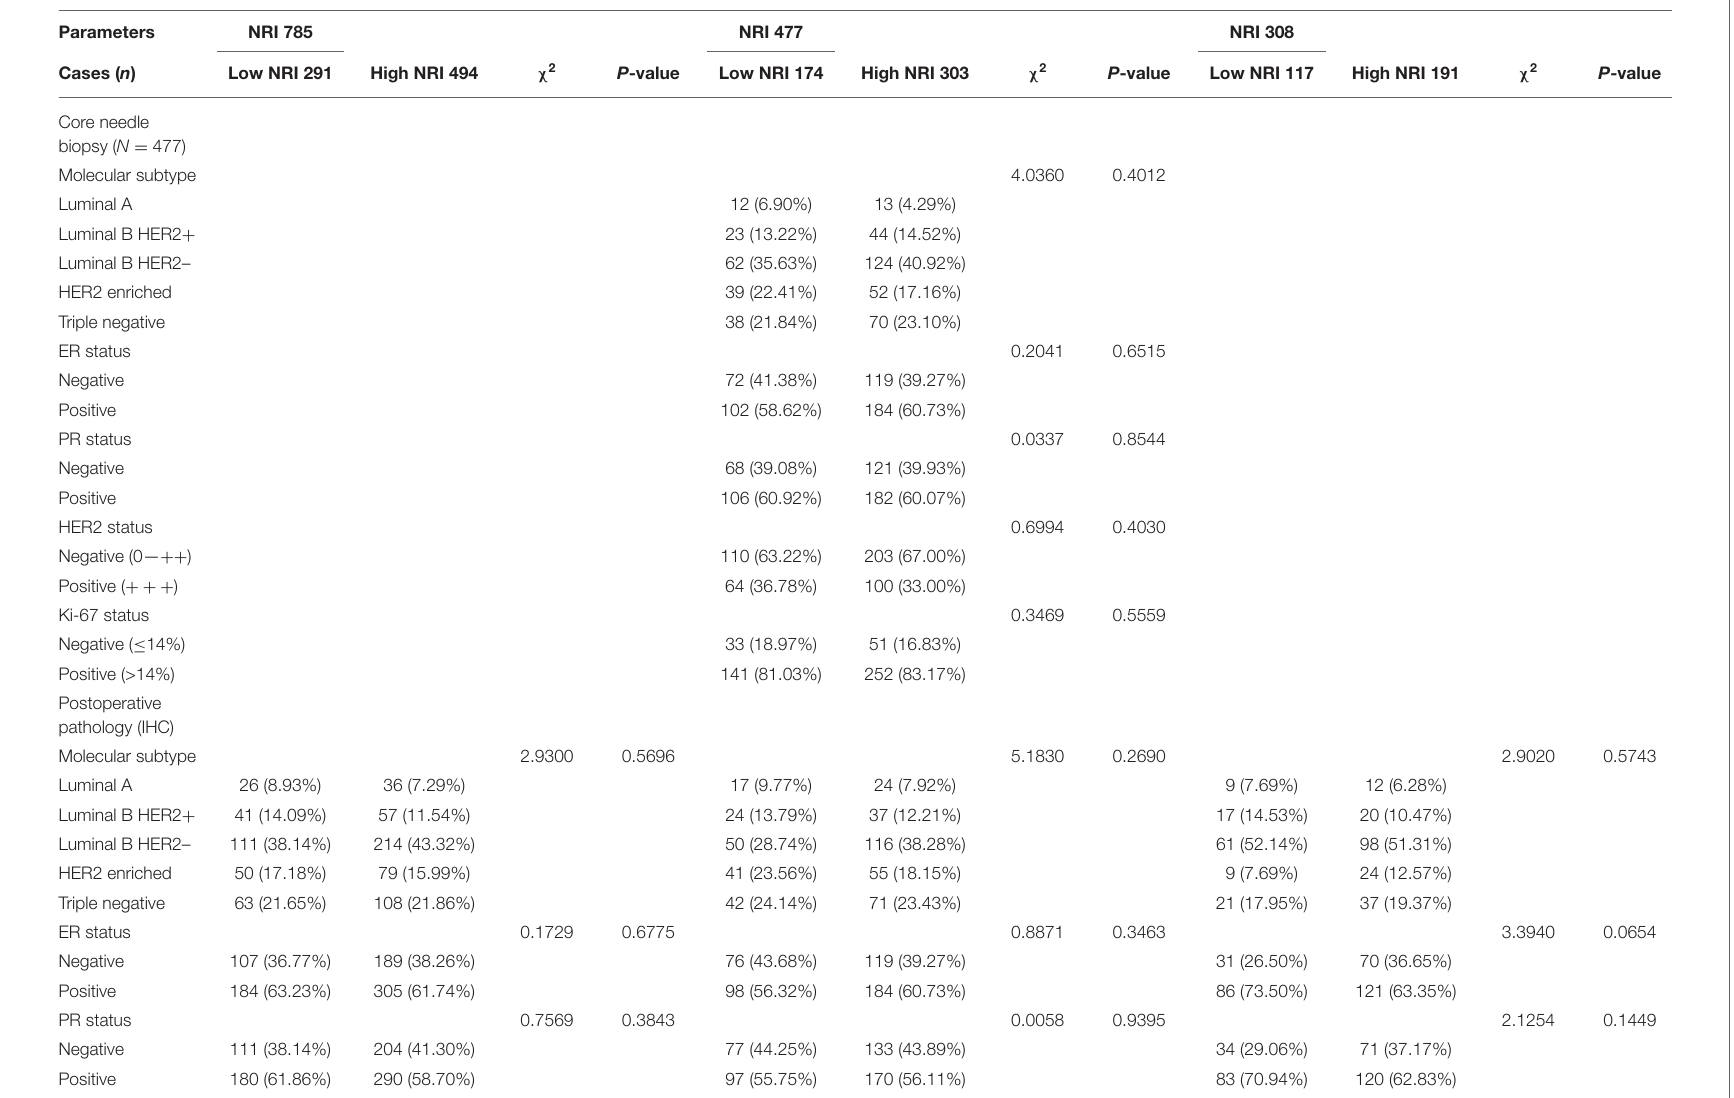
TABLE 4 | The association between molecular subtype and NRI in patients with breast cancer.